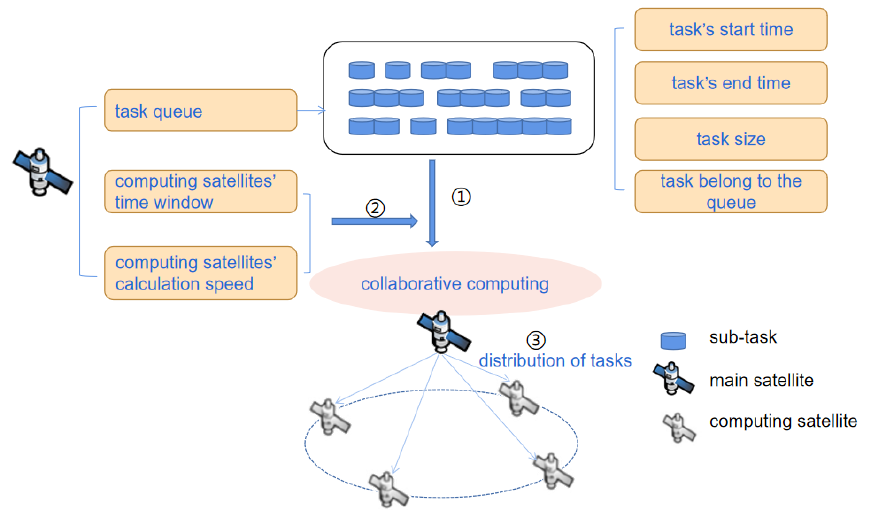
Figure 3. In the process of multi-satellite collaborative computing, the main satellite distributes tasks to the computing satellites according to the tuple information of computing satellites and tasks.